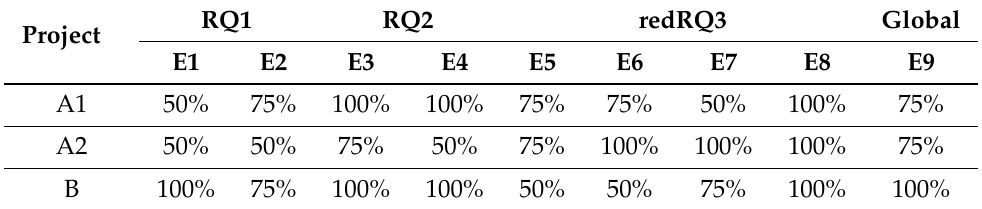
Table 4. External evaluation results (in percentage) of Type A and B projects for each item related to each